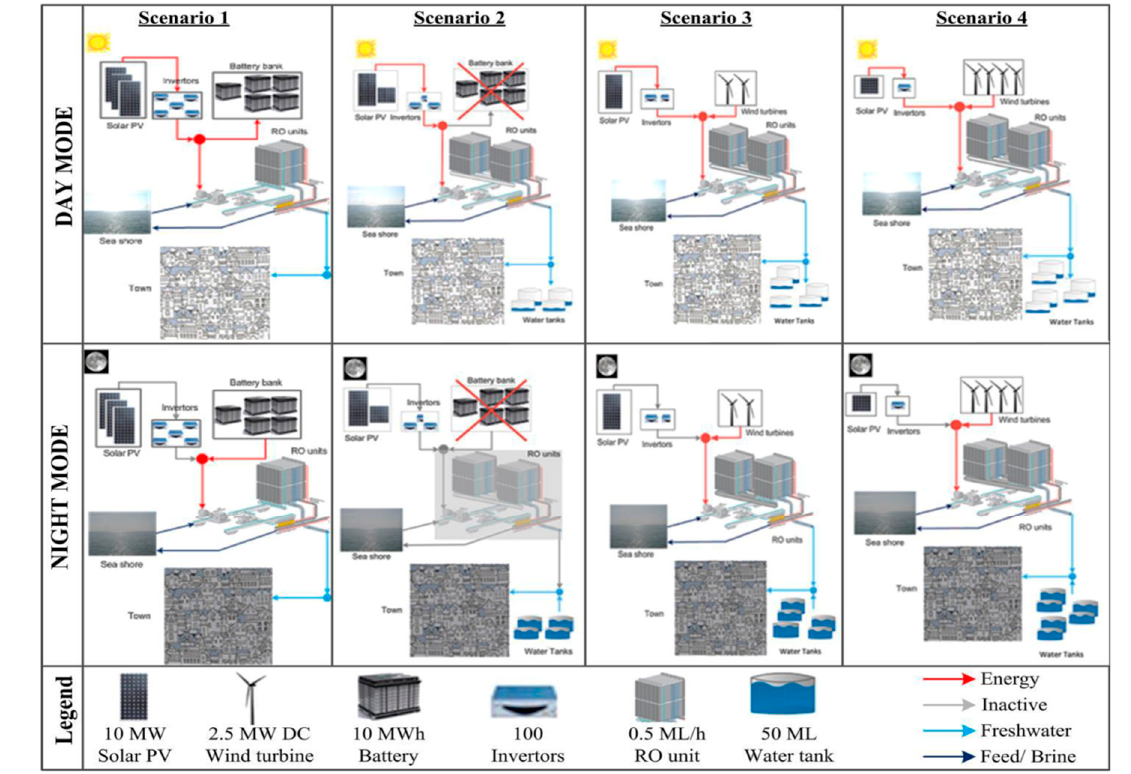
Figure 5. Representation of day and night operations for four scenarios [74], open access.